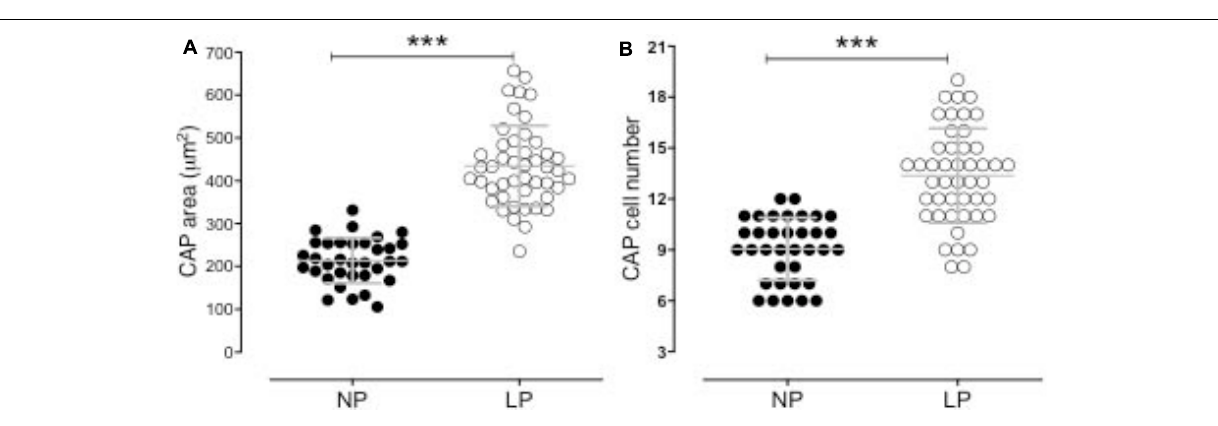
relative to NP offspring, the fold change (FC) of the validated miRNAs was similar to both